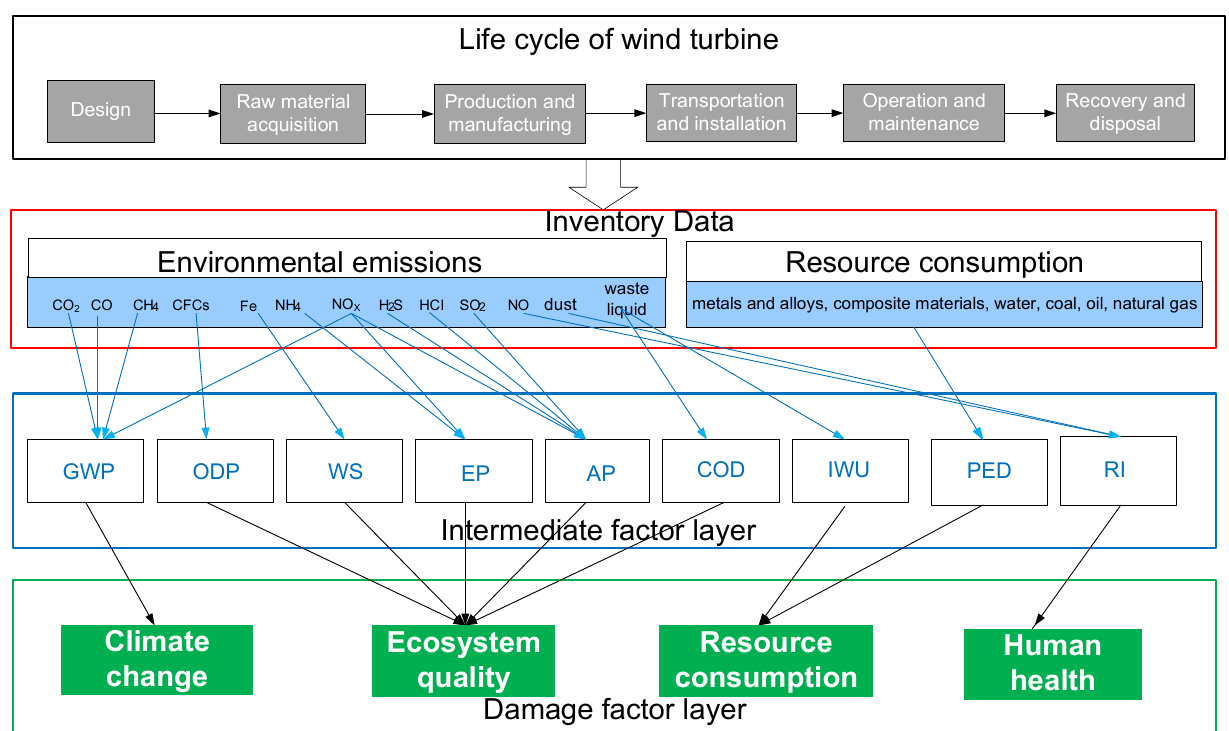
Figure 6. An LCA model for wind turbines based on IMPACT 2002+.